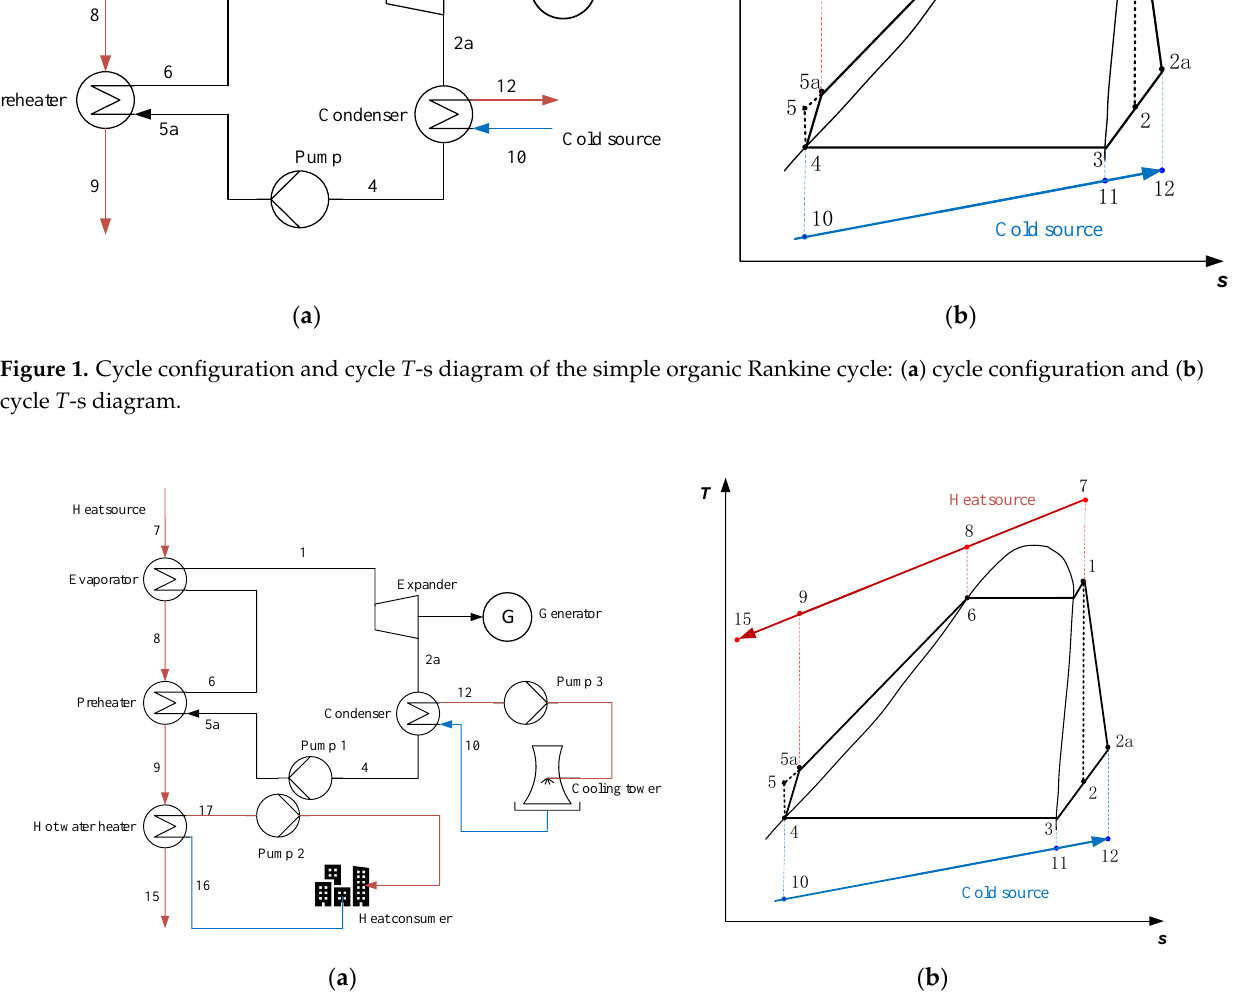
Figure 2. Cycle configuration and T -s diagram of the serial system: ( a ) cycle configuration and ( b ) cycle T -s diagram.